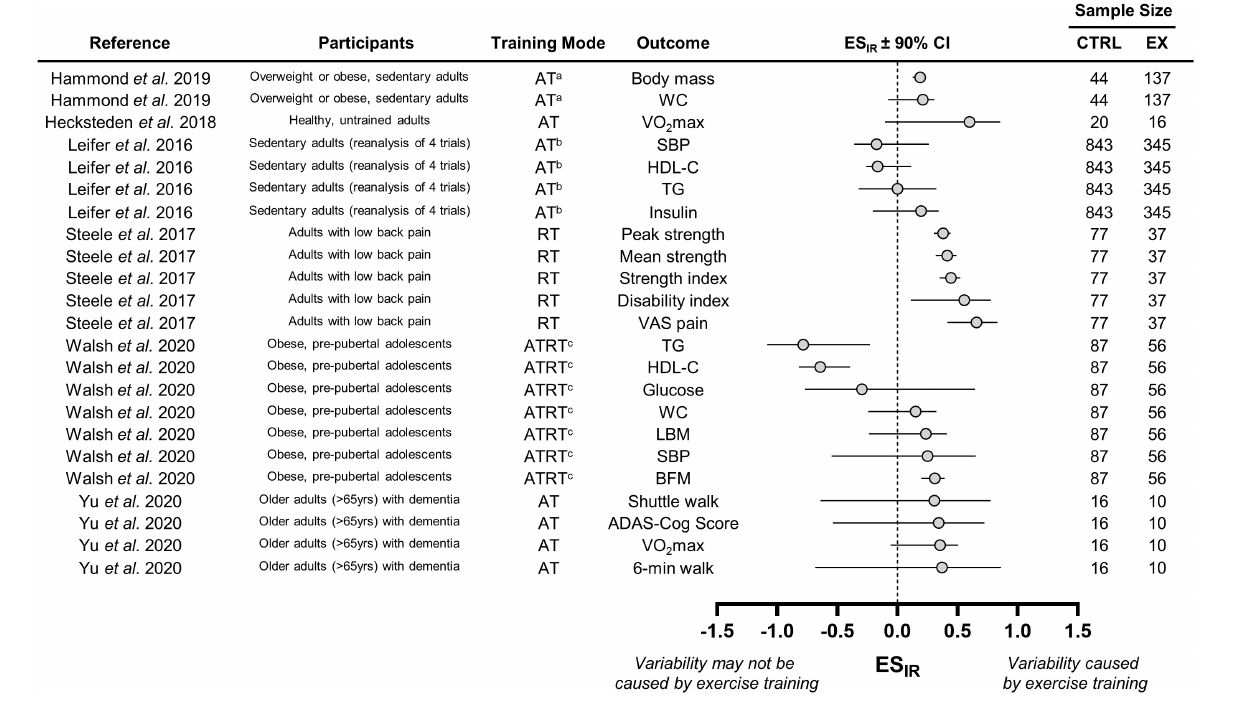
FIGURE 3 | Forest plot of the studies that statistically estimated interindividual differences in trainability. CTRL, control group; EX, exercise training group; WC, waist circumference; VO 2 max; maximal oxygen uptake; SBP, systolic blood pressure; HDL-C, high-density lipoprotein cholesterol; TG, triglyceride; VAS, visual analog scale; LBM, lean body mass; BFM, body fat mass; ADAS-cog, Alzheimer’s disease assessment scale-cognitive subscale. a We combined data from three aerobic training groups (see section “Interindividual Differences in Trainability”); b Data from four trials combined by Leifer et al. (2016); c We combined data from the three training groups (see section “Interindividual Differences in Trainability”), which included an aerobic, resistance, and combined training group.